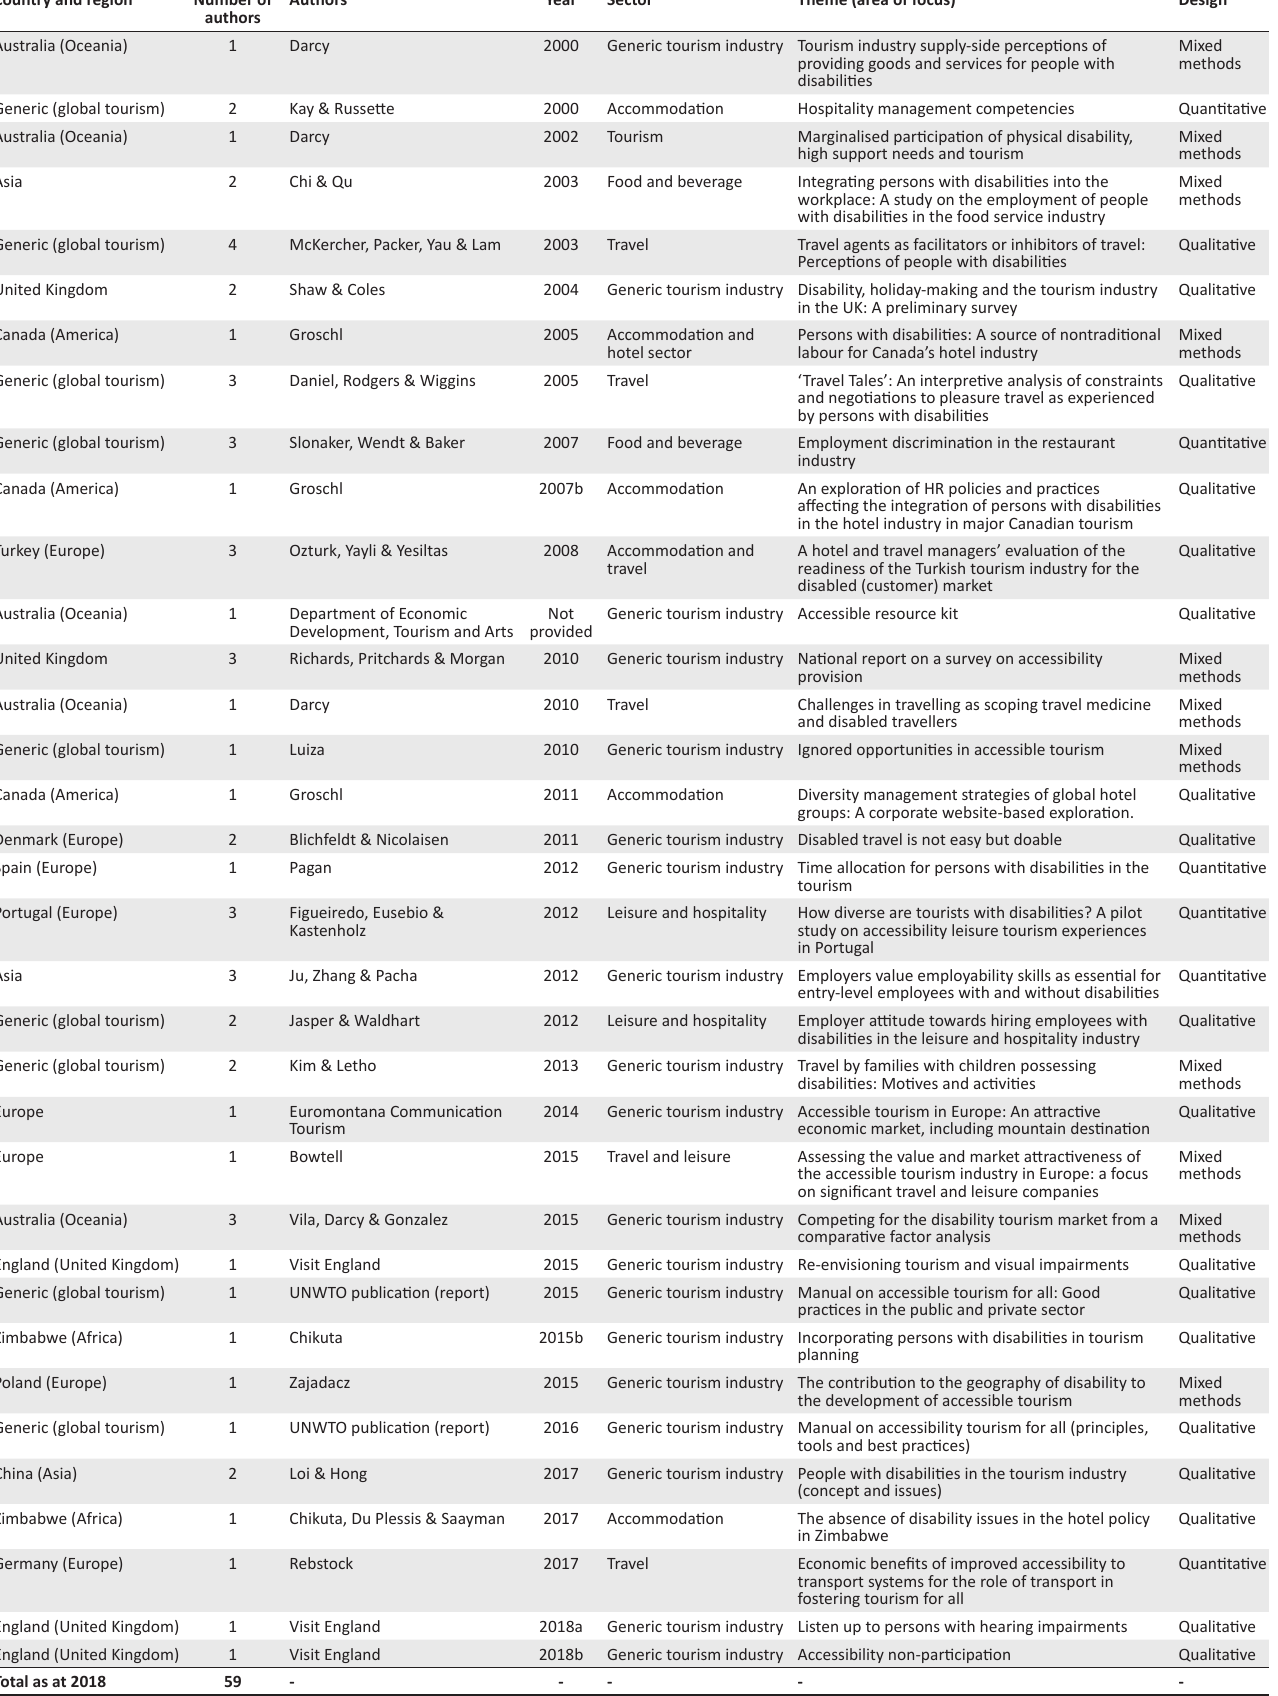
TABLE 5: The tourism supply: inclusion of disability, impairments and disabled people in sequential order of years from 1990 to 2018. Country and